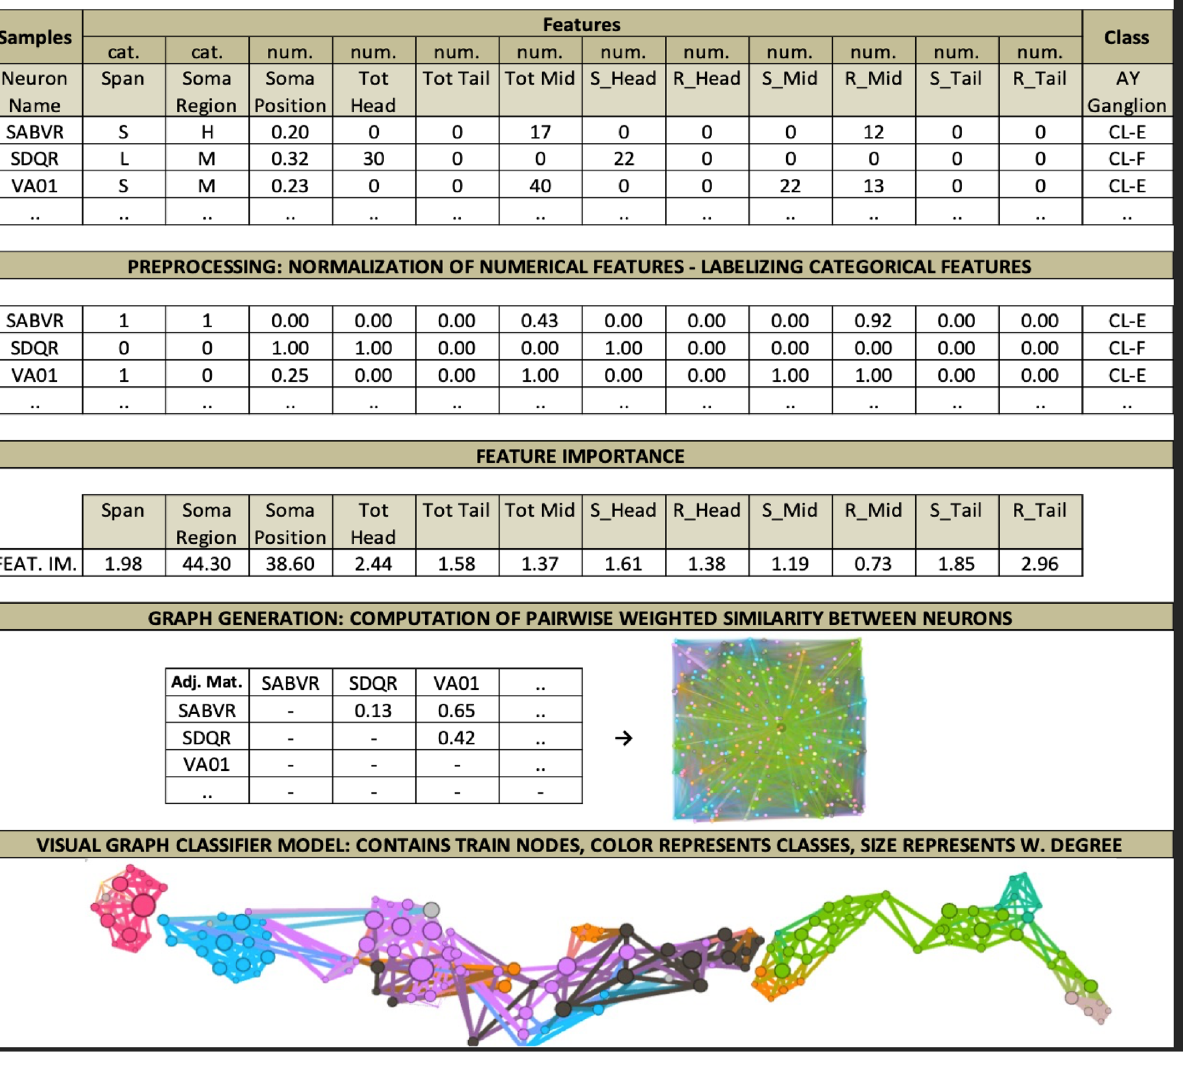
Figure 5. From raw data to GCM demonstrated on C. elegans